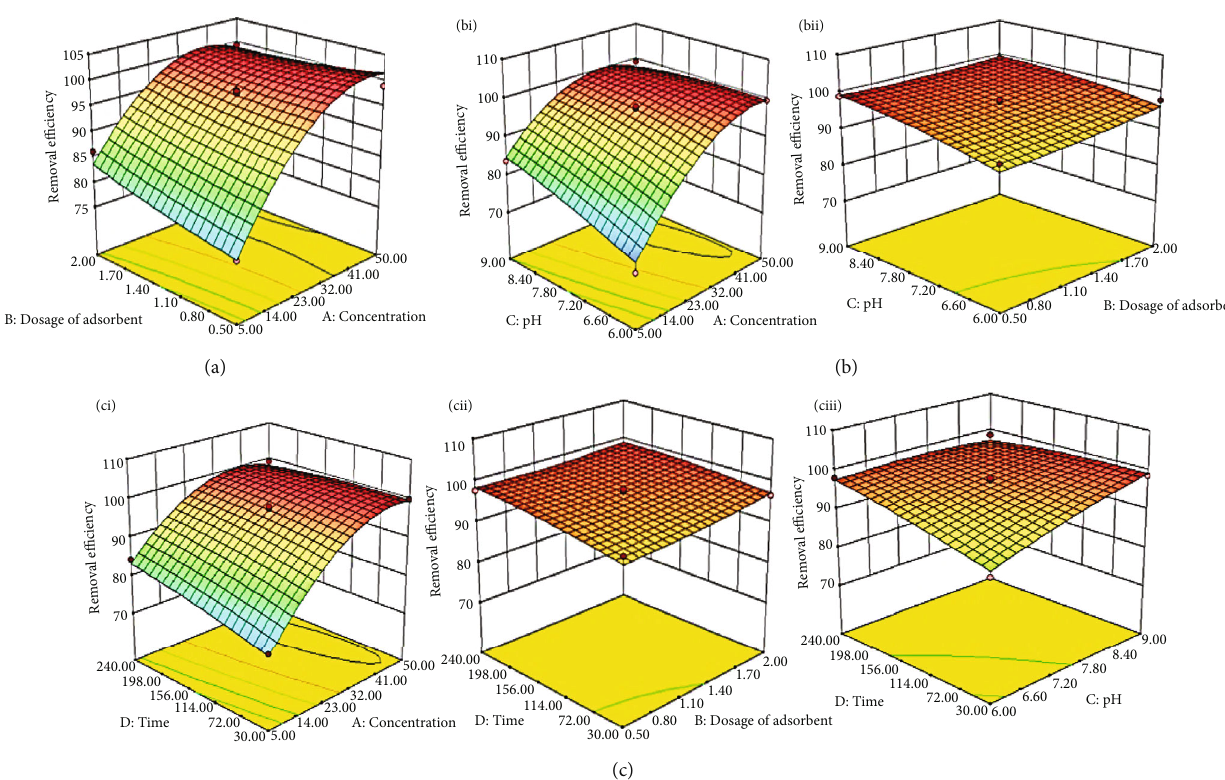
Figure 3: 3D surface plots comparing the percentage of Congo red removed with breadfruit leaf biochar vs. (a) concentration and dosage of biochar, (b, i) concentration and pH, (b, ii) pH and dosage of biochar, (c, i) time and concentration, (c, ii) time and dosage of biochar, and (c, iii) time and